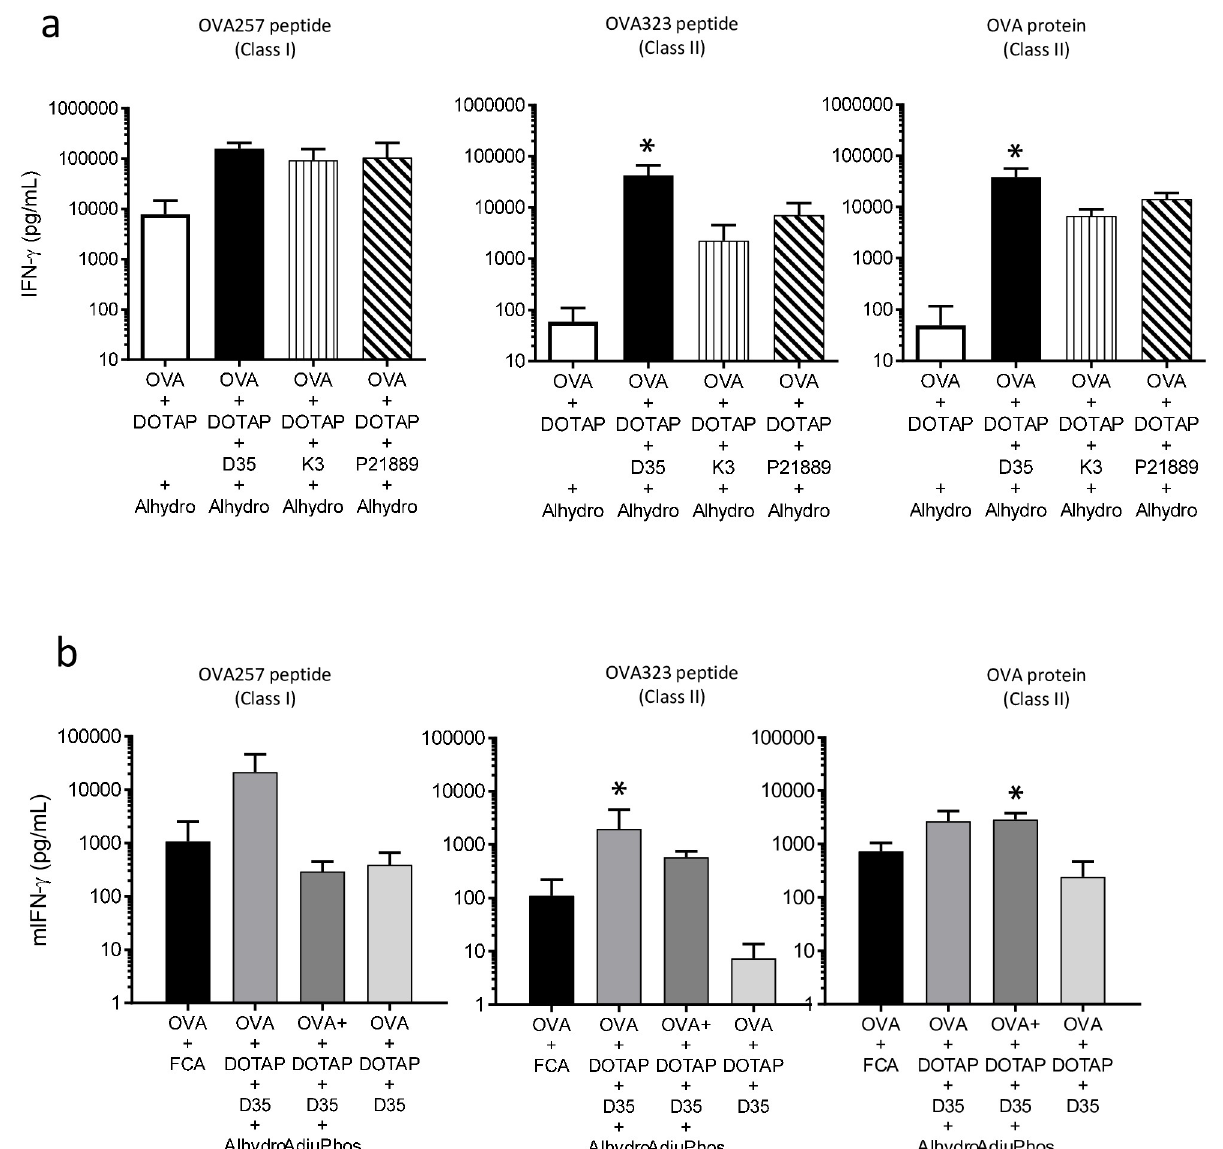
10 μ g), and aluminum salt (Alhydrogel or AdjuPhos; each 40 μ g) in Glu/PBS buffer were used. Seven days after immunization, splenocytes were collected and stimulated with OVA257-264 peptide to induce CD8 + T cell response, and OVA323-339, or OVA protein to induce CD4 + T cell response. After 24 h, the concentration of mouse IFN- γ in the culture supernatant was measured by ELISA. (a) Three different CpG comparisons were performed. (b) Comparison of Alhydrogel and Adjuphos in Glu/PBS buffer. The bar graph indicates the mean + SD of cytokine concentrations derived from three mice per group. Statistical significances compared with OVA/DOTAP/D35 (without Alhydrogel or Adjuphos) are shown by asterisks in the bar graph; � p <